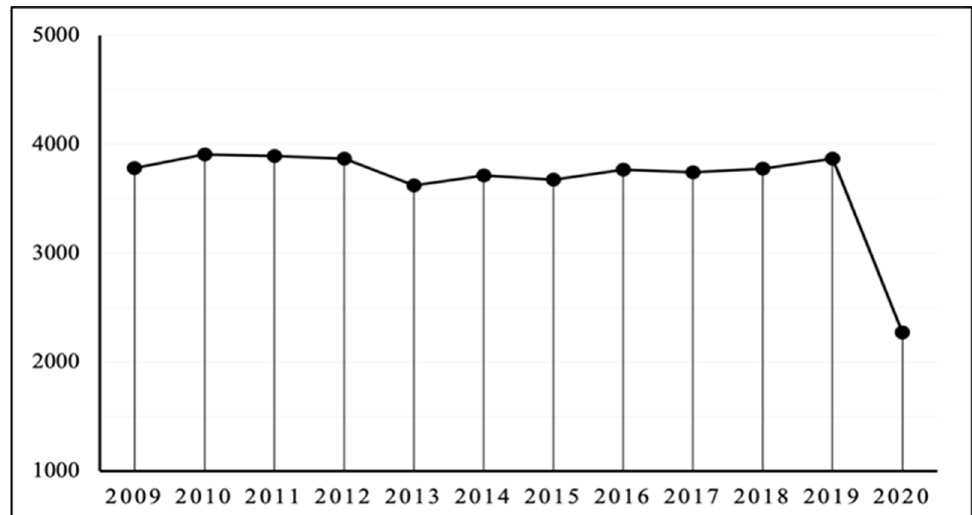
Figure 7. Passenger transportation by urban public means of transport between 2009 and 2020 in Poland in millions of people (own study, based on [45]).